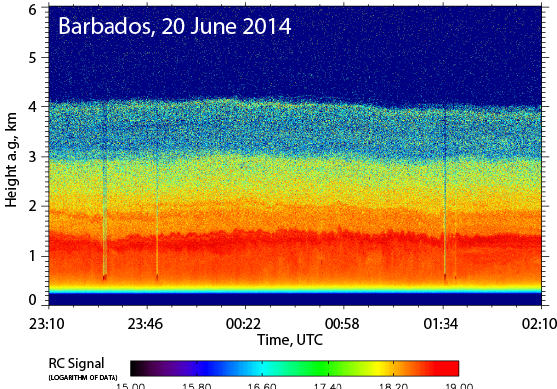
Figure 1. Lidar range-corrected signal at 1064 nm.